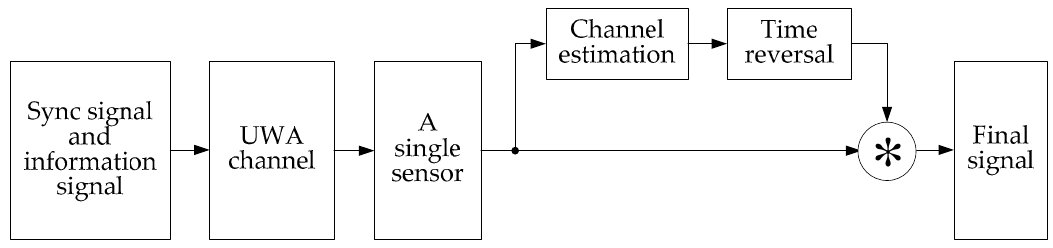
Figure 3. The block diagram of single element TRM.